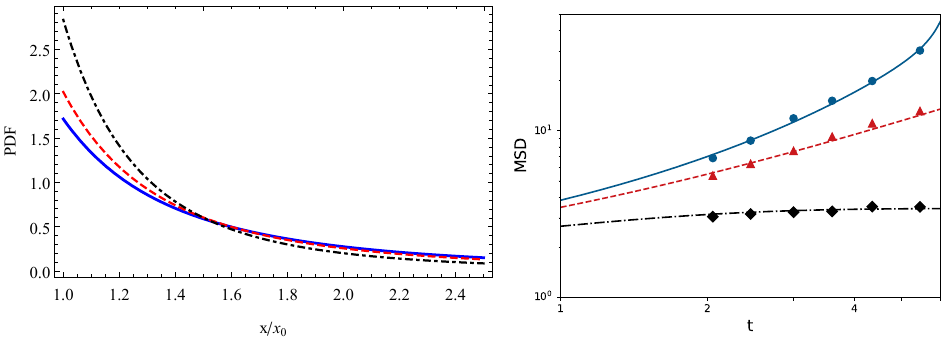
Figure 11. Left panel: PDF (85) at t = 2; right panel: MSD (88) for D = 1, x 0 = 1, v = 1, and r = 0.7 (blue solid line), r = 1 (red dashed line), and r = 2 (black dot-dashed line).